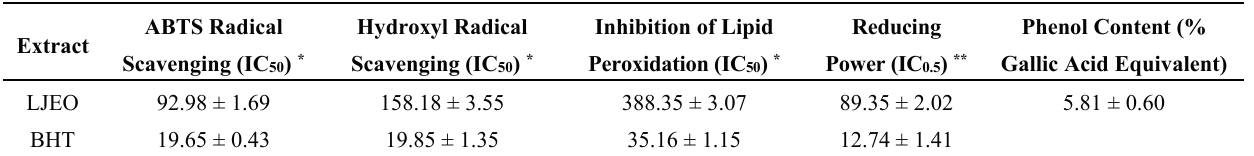
Figure 4. DPPH scavenging potential of ( A ) LJEO and ( B ) BHT as a reference. The results are the mean value of three independent replicates; values with different superscript letters in each section are significantly different at p < 0.05. The superscript letter “ab” or “bc” on letter “a” or “b” and “b” or “c”. Table 3. Free radical scavenging, inhibition of lipid peroxidation, and reducing power of Laminaria japonica L. essential oil